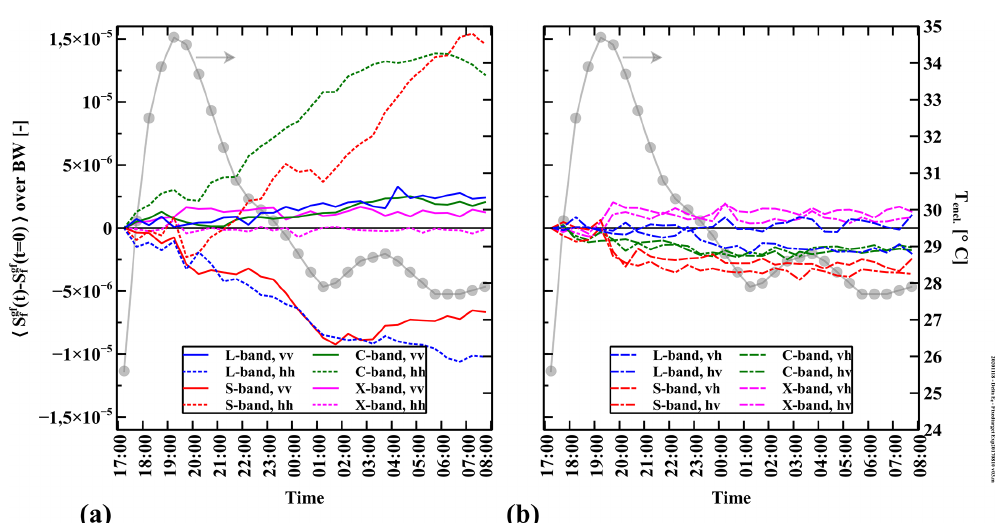
Figure E1. Measured radar return from a fixed target over a varying enclosure temperature T encl . Shown times are in local